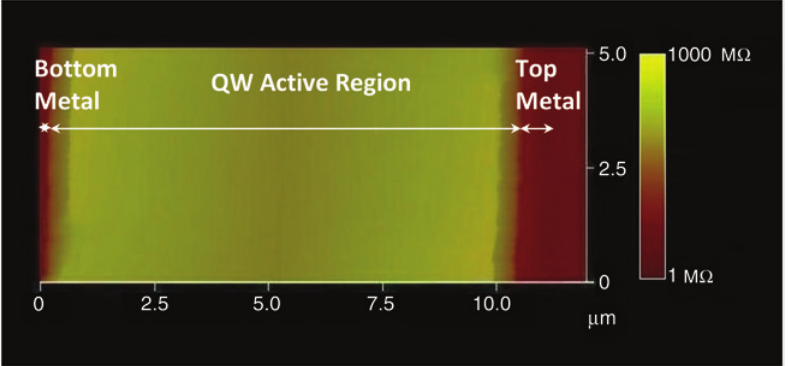
Figure 6: The SSRM image of the transverse cross section of the emission facet of the terahertz QCL device (V843). The DC tip bias is 1.0 V, the scan rate is 0.5 Hz, and the scan area is 5 × 12 μ m 2 .